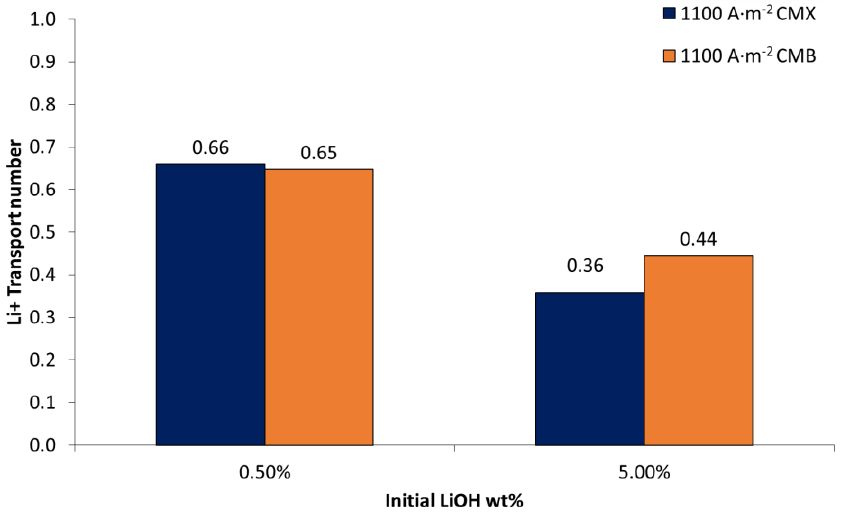
Figure 6. Lithium transport number in cation membranes (CMX and CMB) according to LiOH concentration and current density. LiCl 25 wt%.